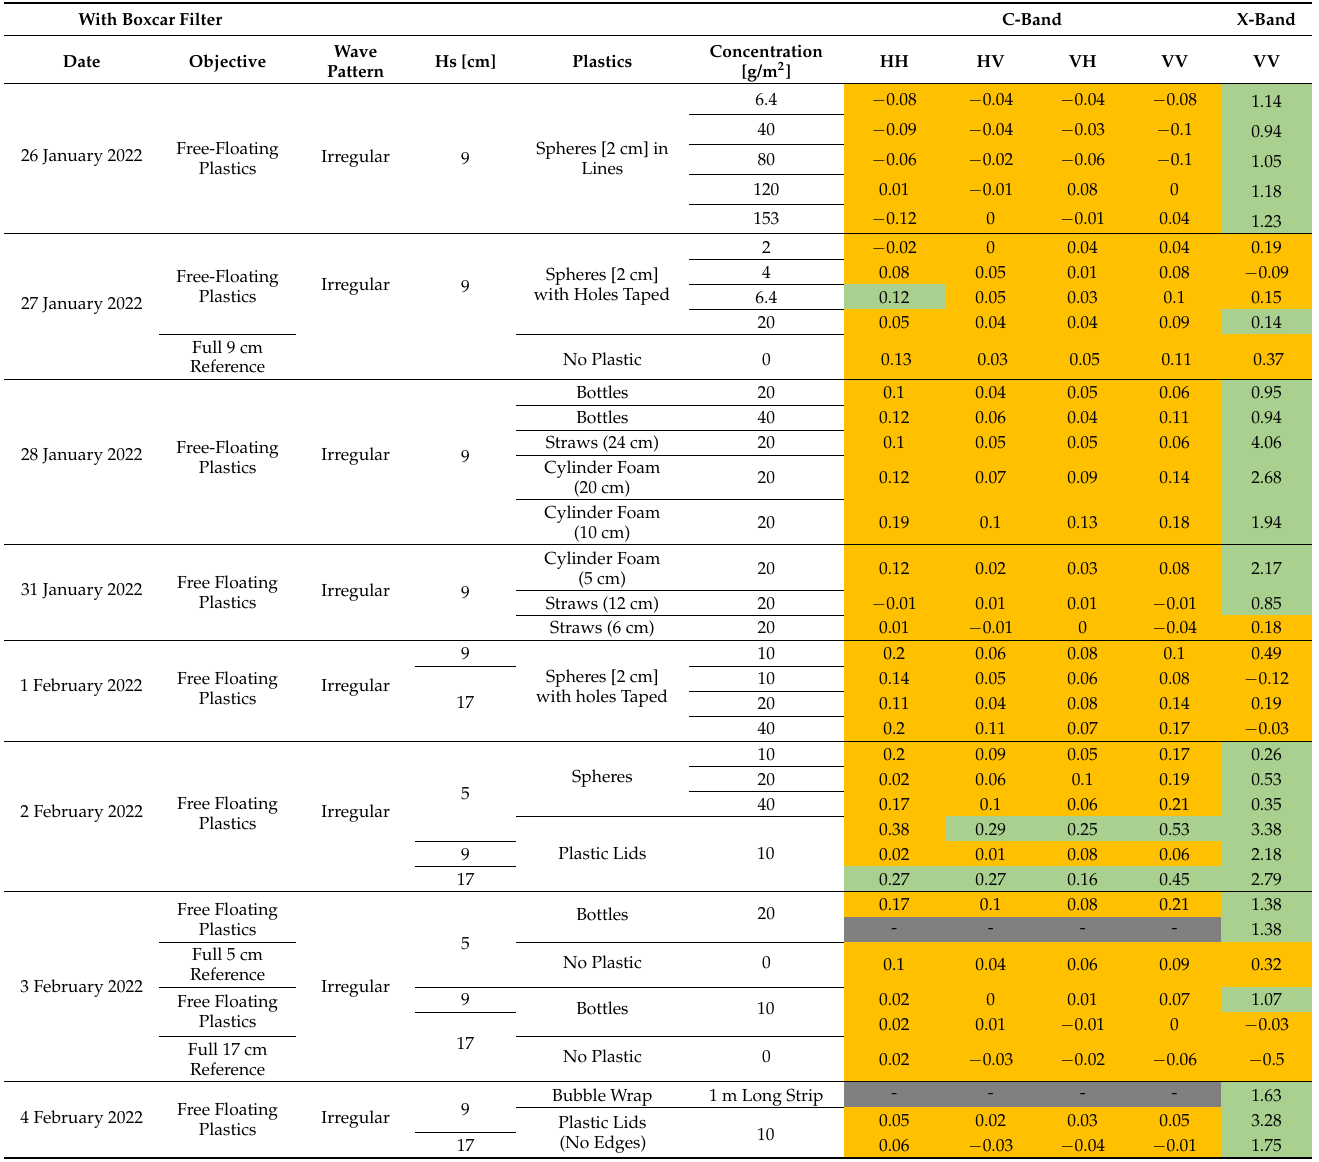
Table 7. Results of statistical analysis undertaken on 2nd campaign measurements with the use of a boxcar filter. Values filling the table are the results of the difference of the reference measurement and test measurement in a linear format. Any value in green shows that the alternative hypothesis was fulfilled; any value in orange shows that the null hypothesis was